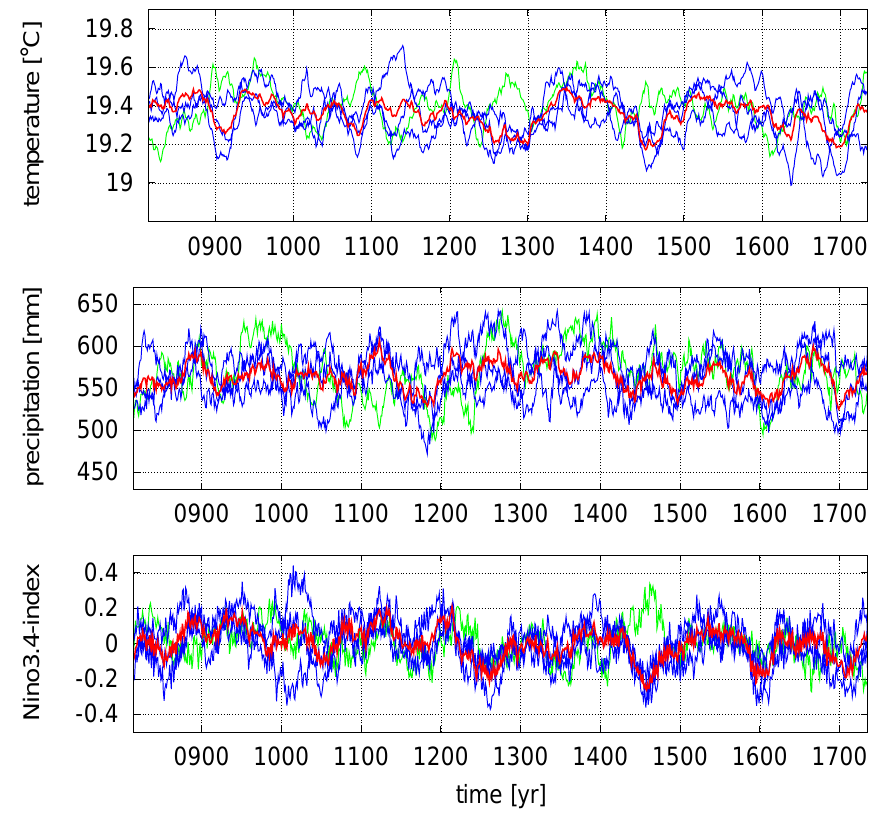
Fig. 2. 30-year running mean of simulated near-surface air temperature (top), precipitation (middle) and Ni˜no3.4-index (bottom) around Rapa Nui for the period 800–1750AD. Shown are the Millennium experiments mil0001 (green), the ensemble members mil0010 , mil0012 and mil0013 (blue) and the ensemble mean